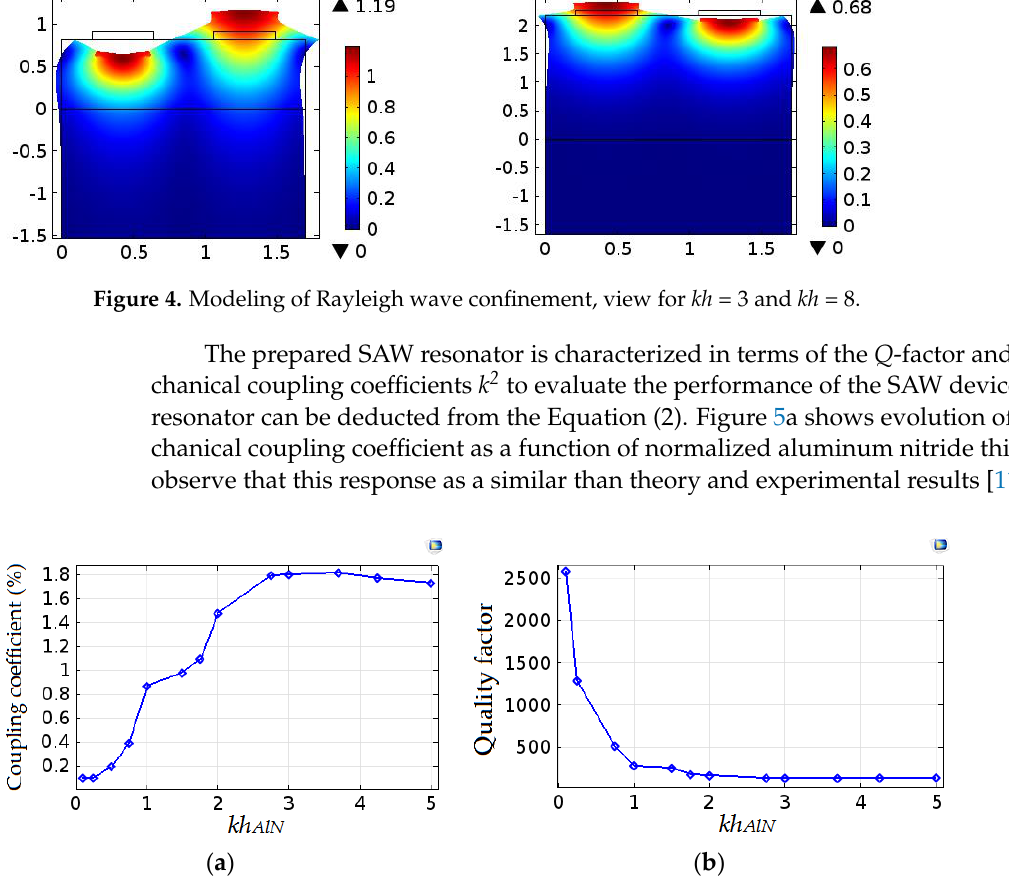
Figure 3 . ( a ) FEM (Finite Element Method) modeling quality factor versus frequency, ( b ) Phase velocity dispersion curve versus normalized AlN (Aluminum Nitride) thickness 𝑘ℎ 𝐴𝑙𝑁 .